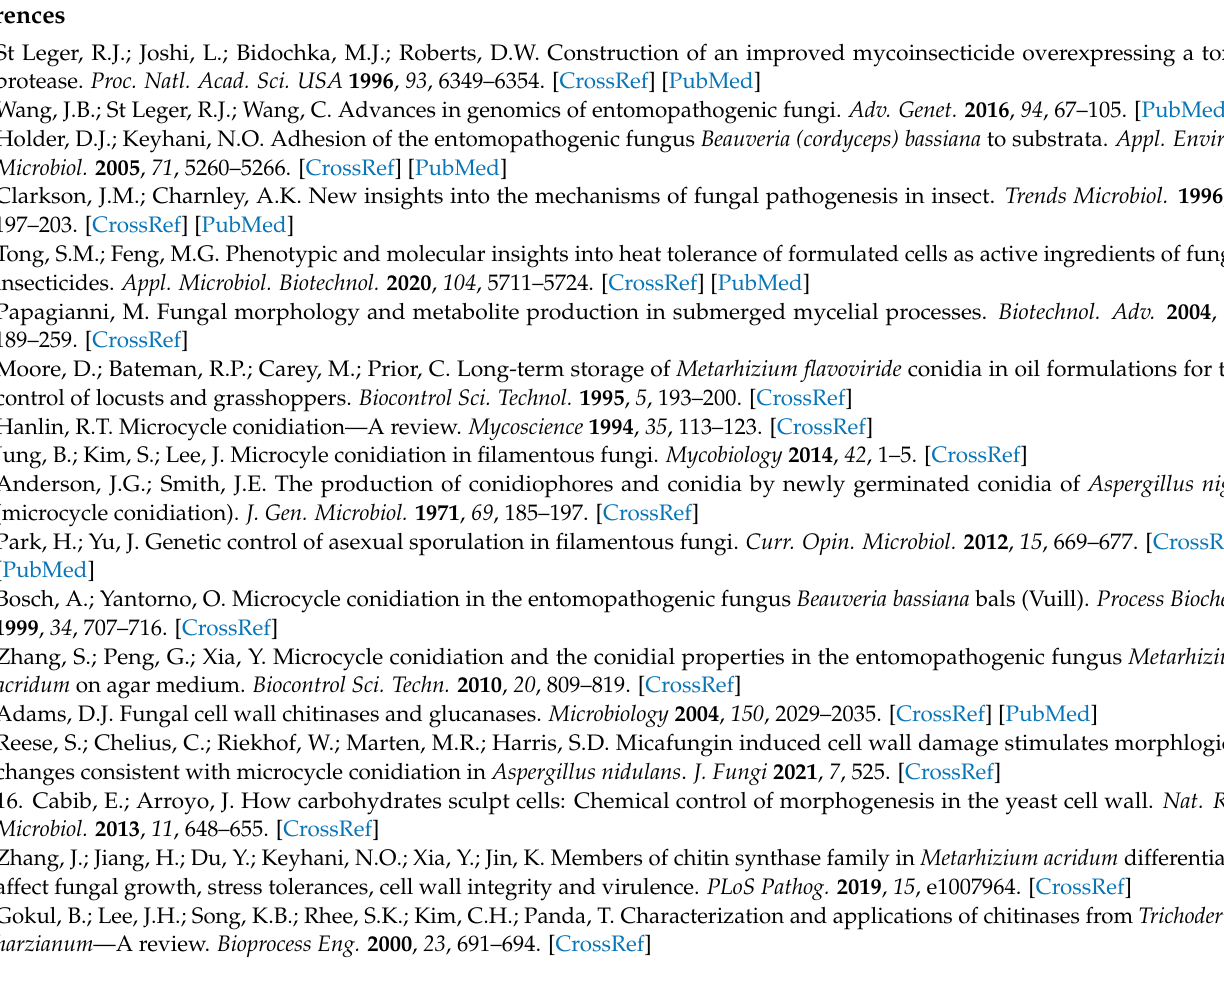
Figure S2: Disruption of key genes, including MaHym1 , MaKic1 , MaTao3 , MaCbk1 and MaMob2 , in MOR pathway and MaAce2 in M. acridum . All mutants were verified by PCR analyses. All primers used in this study were listed in Table S1. Table S1: Primers used in this work. Table S2: Identification of MOR/RAM components in M.